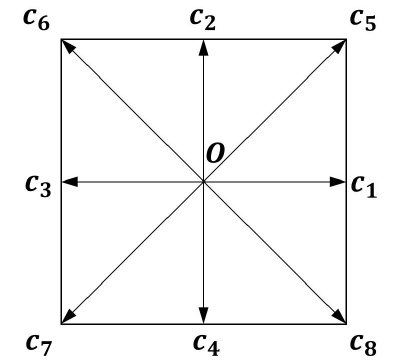
Figure 1. Schematic of the D2Q9 lattice